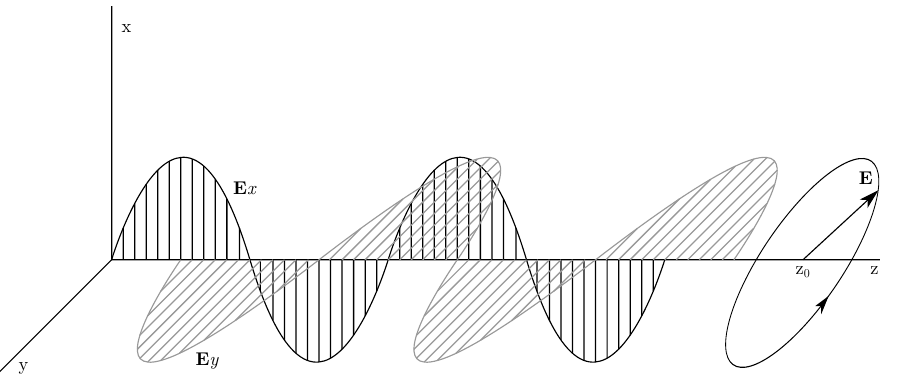
Figure 1. Polarization components of an electromagnetic wave E